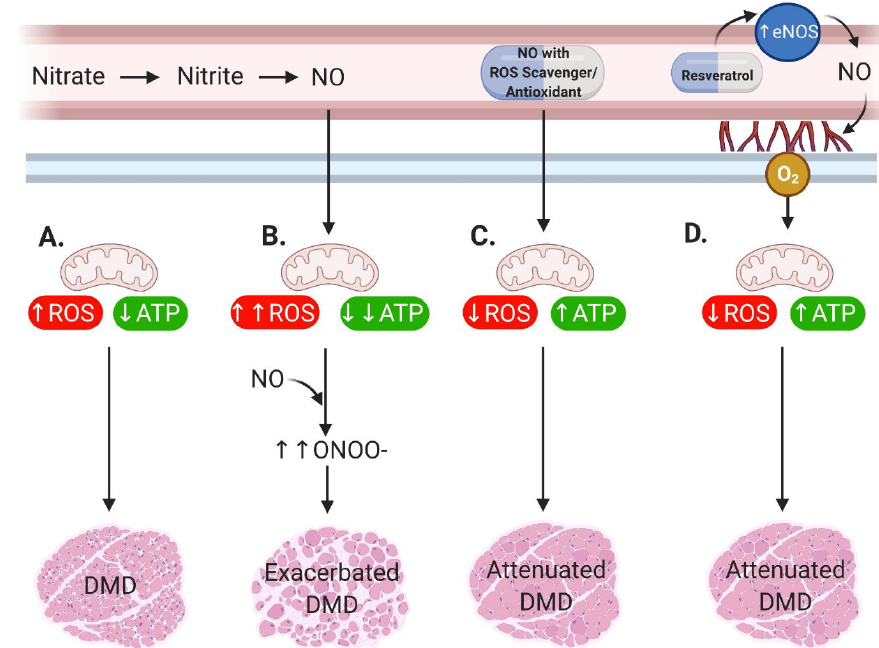
Figure 2. Proposed approach for nitric oxide (NO) therapy in Duchenne Muscular Dystrophy (DMD). ( A ) Dystrophic muscle is characterized by mitochondria which produce elevated reactive oxygen